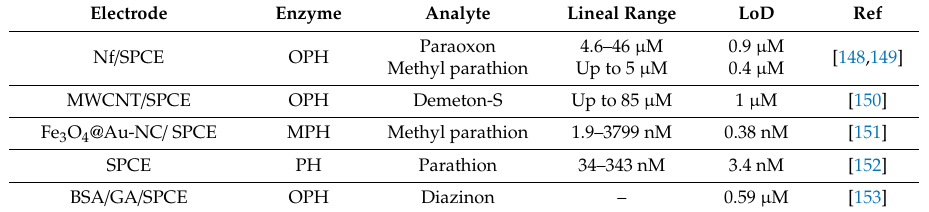
Table 2. Enzymatic hydrolysis-based biosensors reported for pesticides detection on screen-printed electrodes.